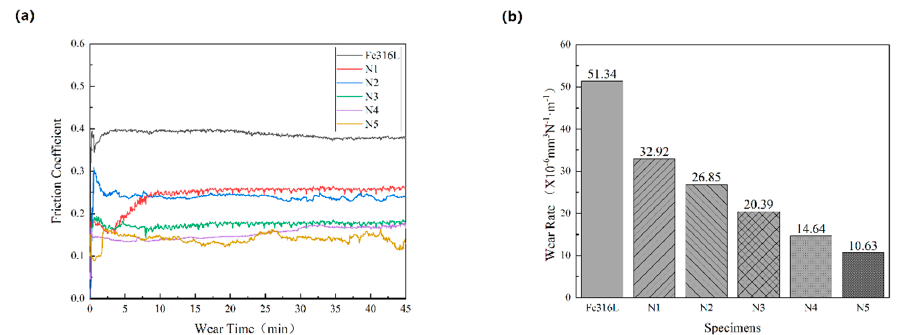
Figure 8. Friction and wear coefficient diagram and wear amount diagram of different cladding layers. ( a ) Friction and wear coefficient diagram of different cladding layers; ( b ) Comparison diagram of wear amount of different cladding layers.